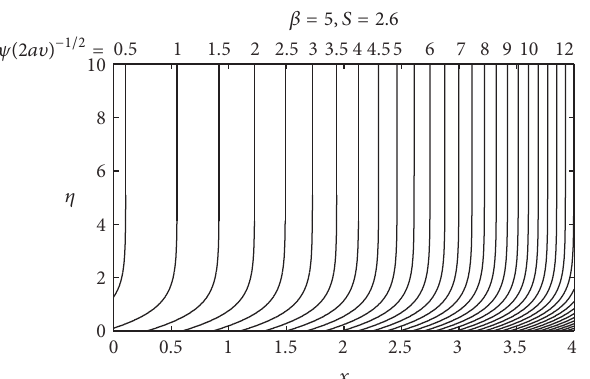
Figure 6: The streamline of the flow for first solution with 𝐿 = 1 .